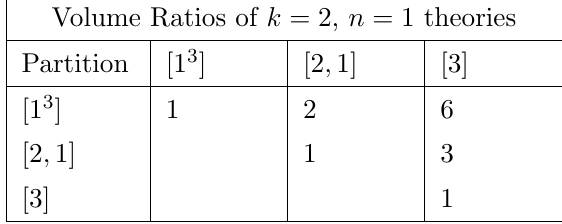
Table 1 . Ratios of Coulomb branch volumes for k = 2, n = 1 theories.